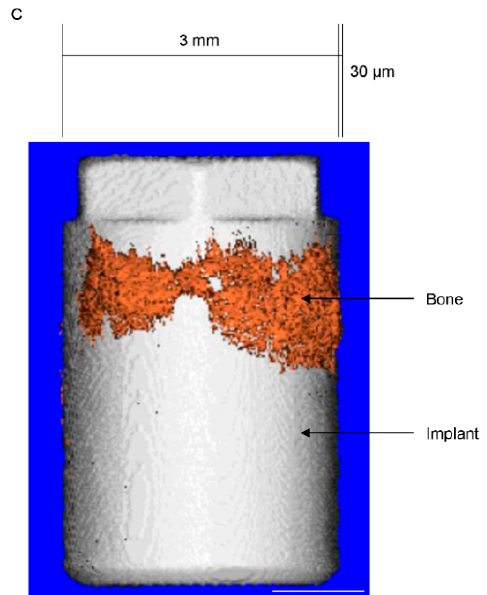
Figure 1. Schematic diagram of the specimens used in this study and the arrangement of the specimens. ( A ) The implant specimens had a simple geometric form: a cylinder that facilitates biomechanical calculations. ( B ) The grades 2 and 4 commercially pure titanium implants were installed into rabbit tibiae according to the Latin Square randomization technique. The distance between the centers of the proximal and distal implants was approximately 10 mm. ( C ) The three-dimensional (3D) bone–implant interfaces were reconstructed via digital image processing. A bone–implant contact surface is shown here. Note that the image of the bone is cut and processed in 30- µ m thicknesses.